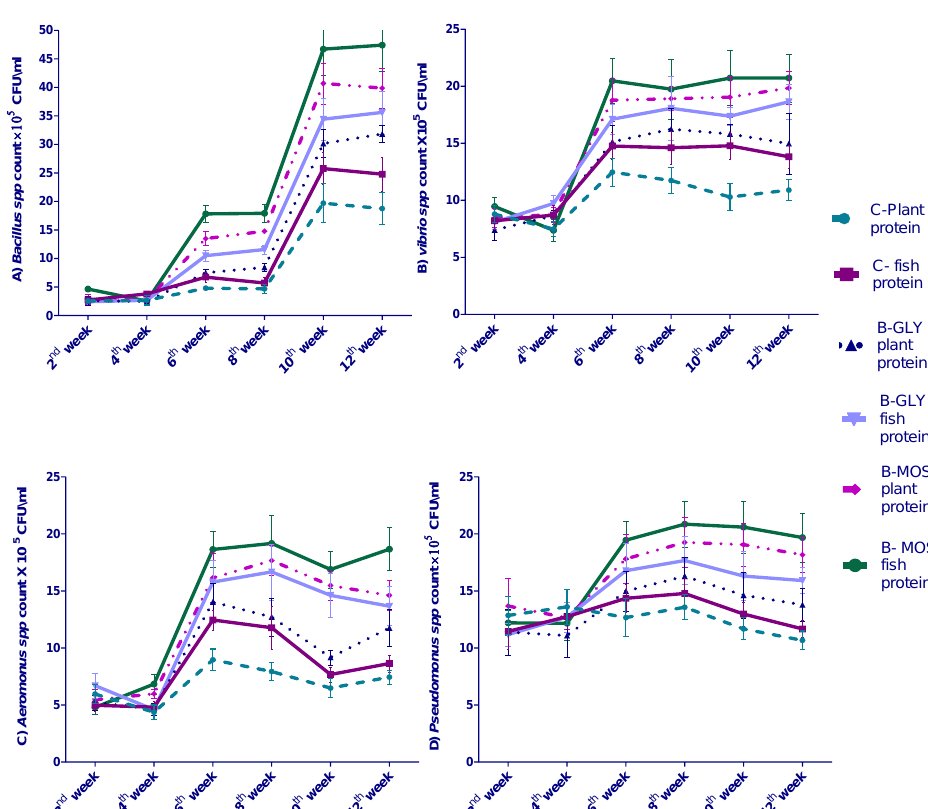
Figure 1. Water bacterial count for Bacillus spp., Aeromonas spp., Vibrio spp. and Pseudomonas spp. every two weeks of the 12-week experiment (cfu/mL) (data are expressed as mean ± SEM).